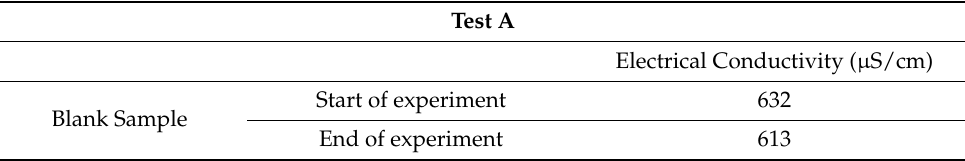
Table 3. Electrical conductivity values for the blank sample in Test